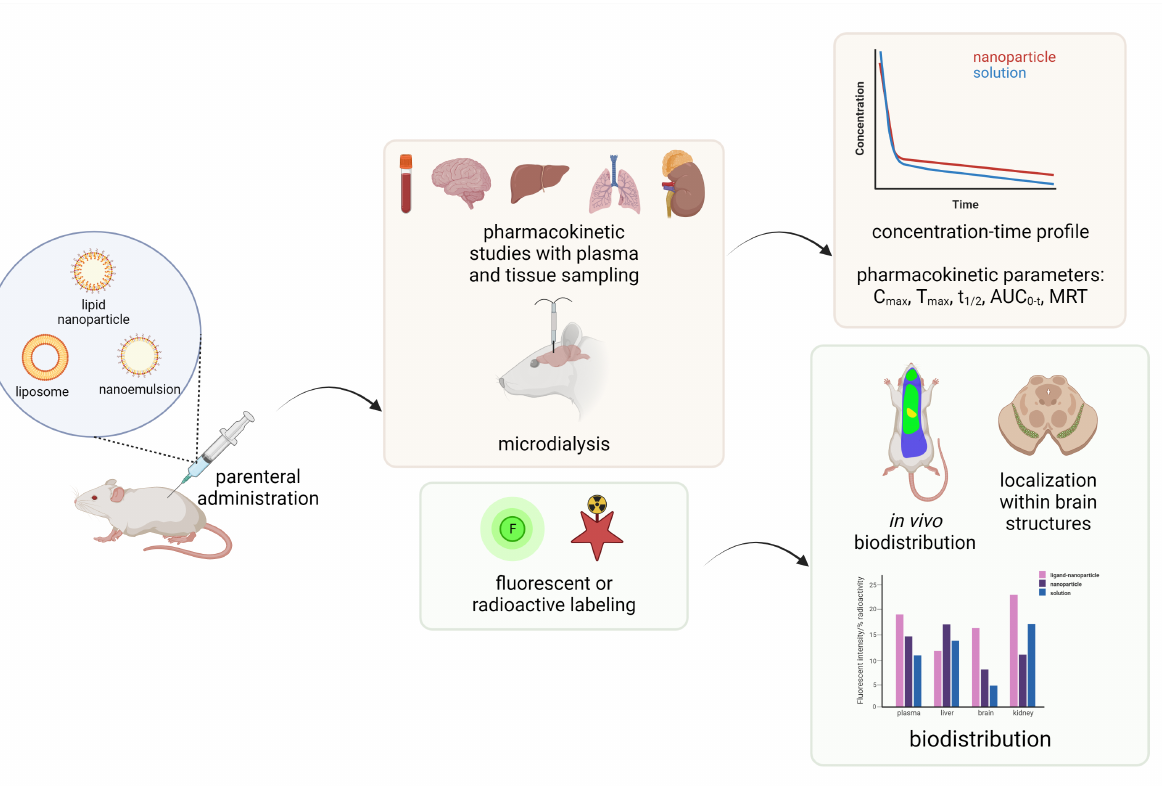
Figure 4. Different methodologies used in pharmacokinetic and biodistribution studies of lipid nanocarriers. Created with BioRender.com (accessed on 29 December